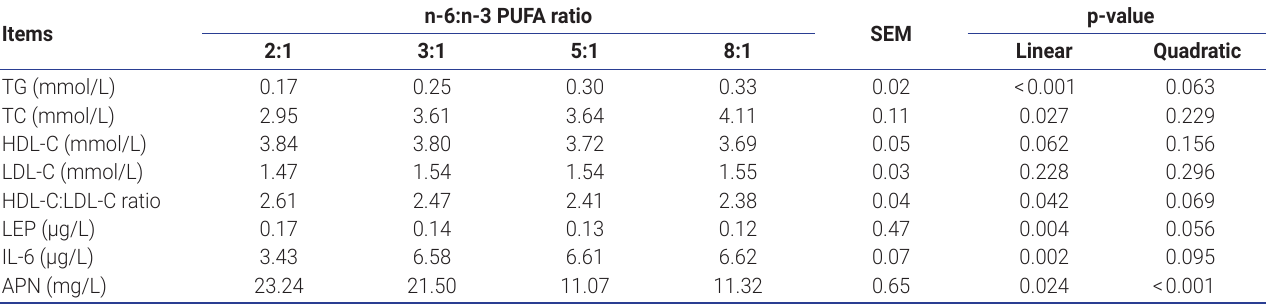
Table 5. Effects of dietary n-6:n-3 PUFA ratios on serum lipid and adipocytokine profiles of finishing pigs Items